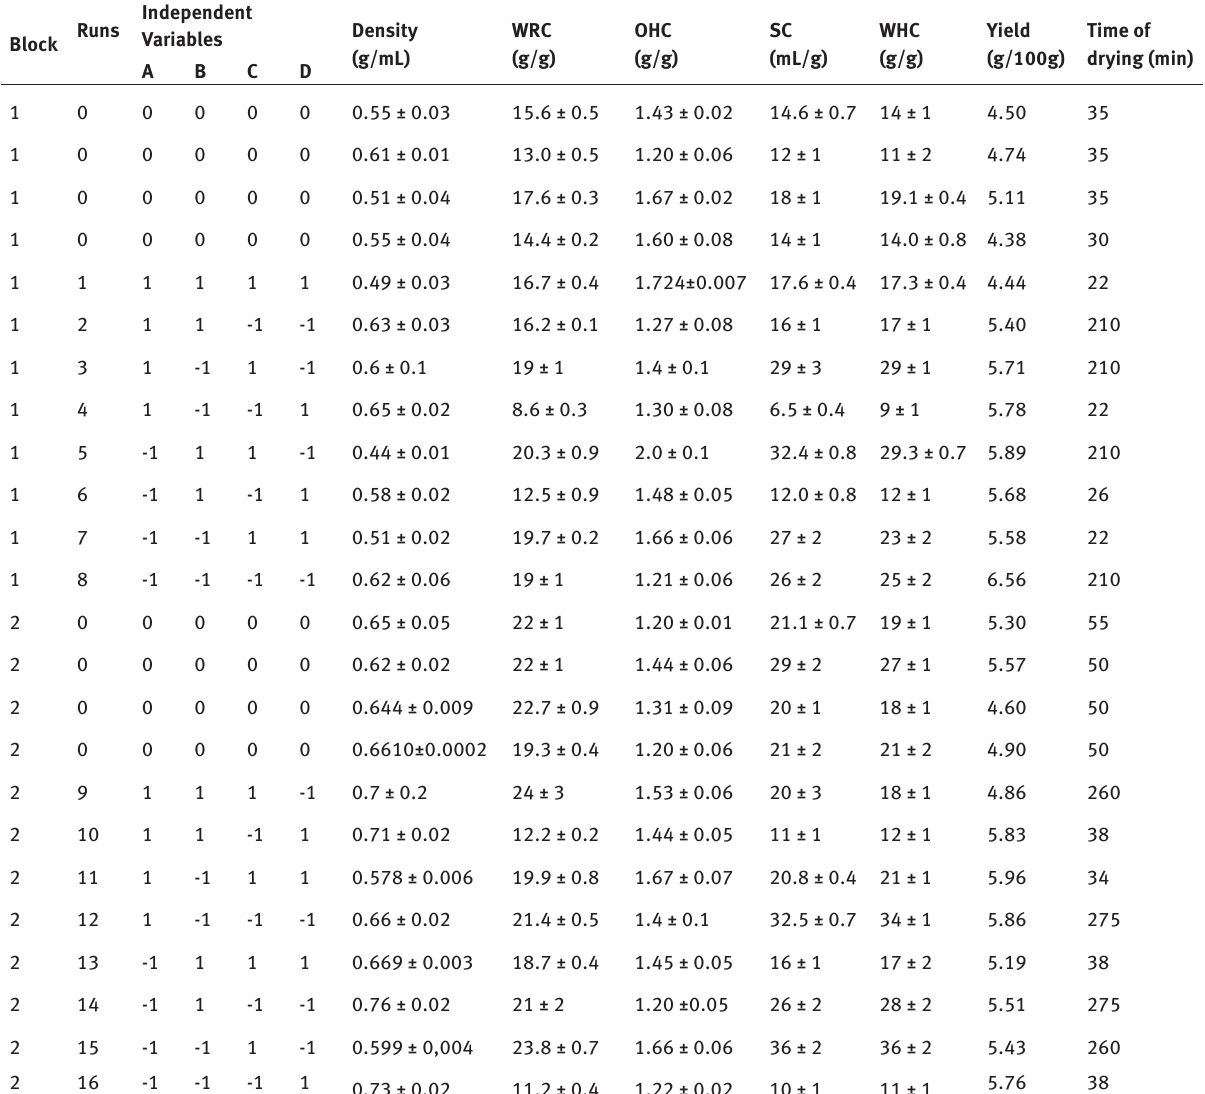
Table 2: Properties of fractions enriched in dietary fiber isolated from (Prunus persica L.) and microwave dried